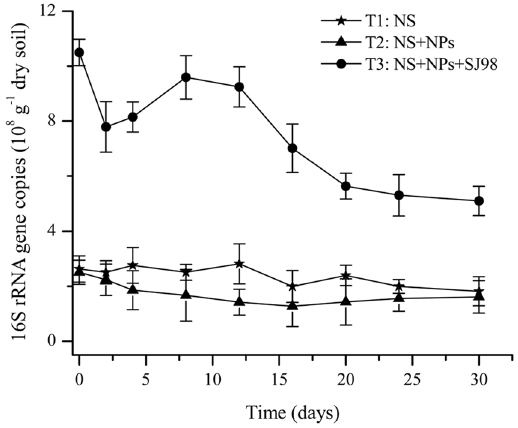
Figure 3. Quantitative changes of total 16S rRNA genes in non-sterile soil microcosms over time by real-time PCR. Values are means ± standard deviation (n = 3). NS: native soil, NPs: nitrophenols, and SJ98: Burkholderia sp. strain